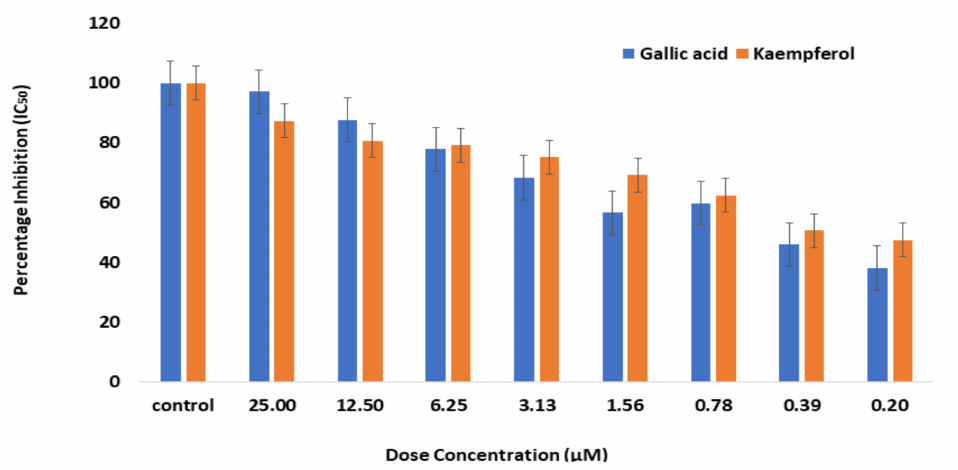
Figure 7. The percentage inhibition of α -glucosidase by increasing concentrations of gallic acid and kaempferol. The resulting IC 50 is 0.37 µ M for gallic acid and 0.87 µ M for kaempferol. This data was taken in triplicates (n = 3) with SD ± mean